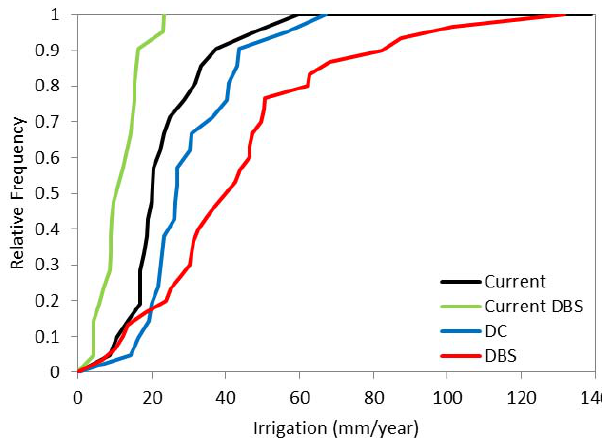
Fig. 8. Cumulative histogram of the yearly irrigation (on the agri- cultural areas) for current and future scenario with both DC and DBS bias correction.